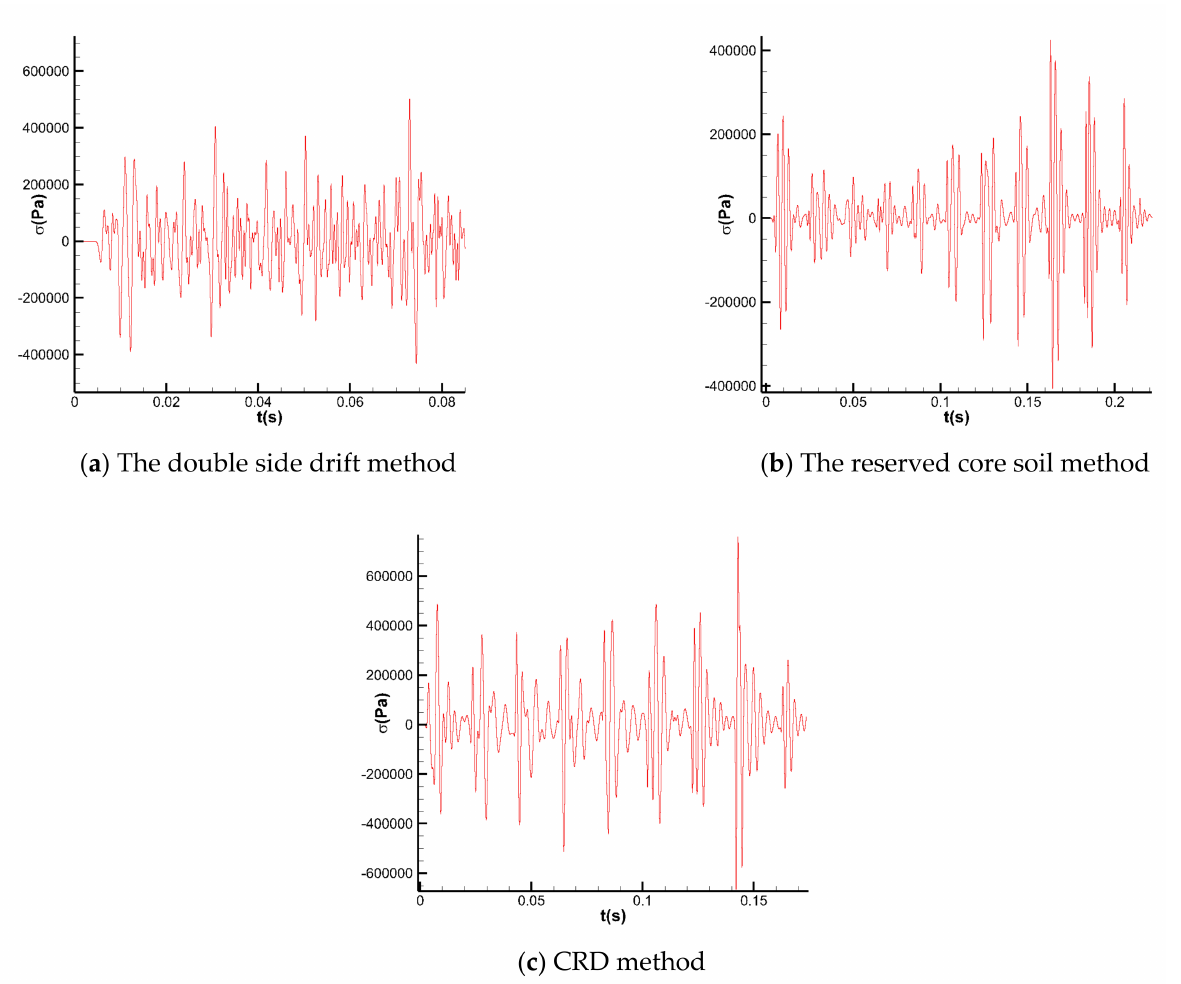
Figure 16. Stress and time curve of monitoring element under different blasting excavation construc- tion